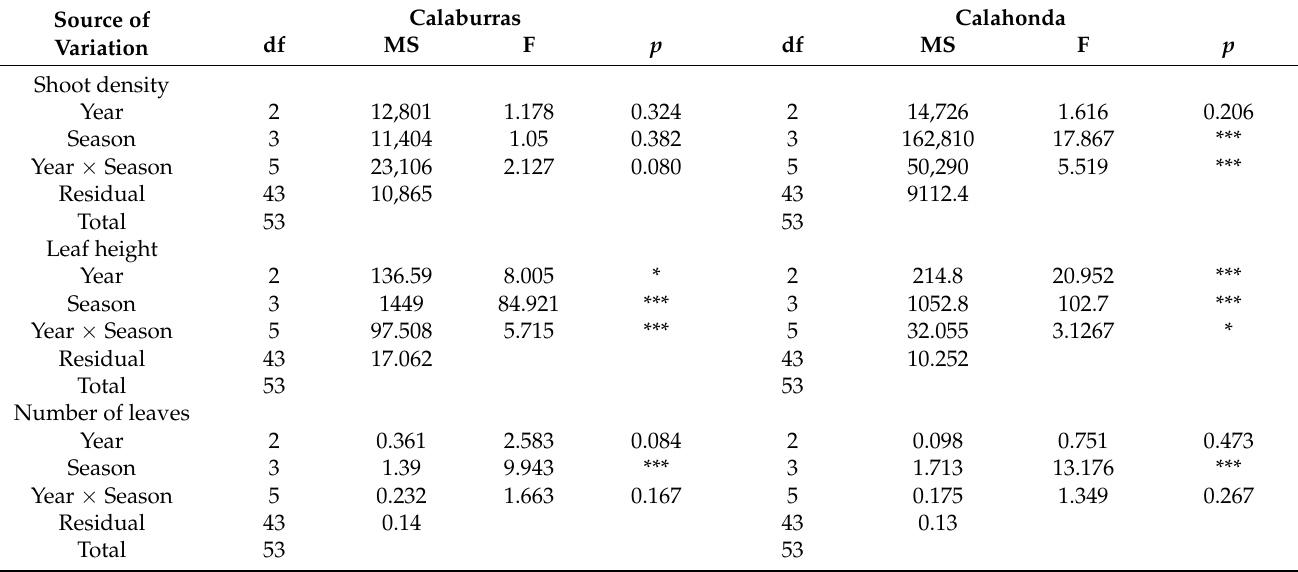
Table 3. Results of two-way PERMANOVA tests for differences in the shoot density, maximum leaf height and number of leaves per shoot of Posidonia oceanica between seasons and years. Significant differences * p < 0.05; *** p < 0.001.